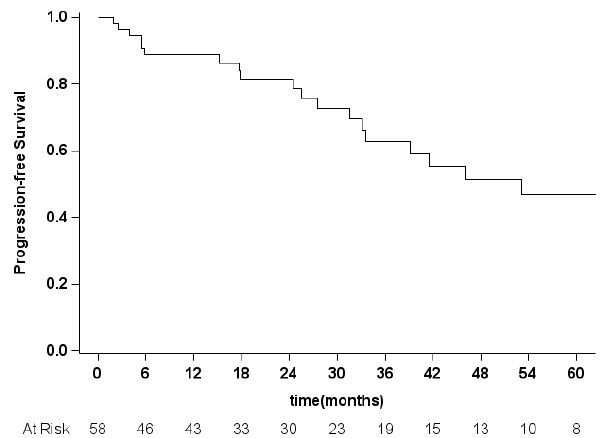
Figure 2. Kaplan–Meier progression-free survival Figure 2. Kaplan – Meier progression-free survival curve.